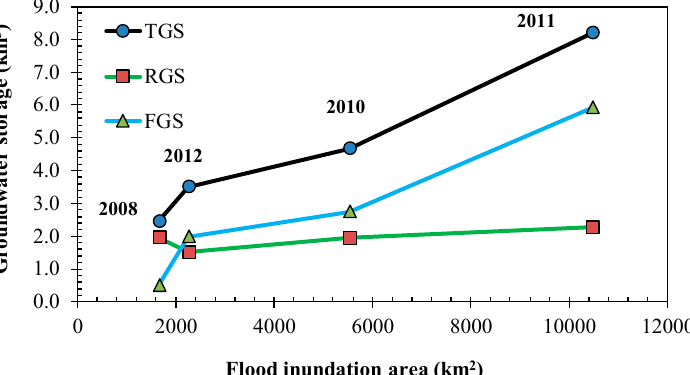
Figure 8. The Relationship between flood inundation areas and groundwater storage in the UCP’s flood-prone area.